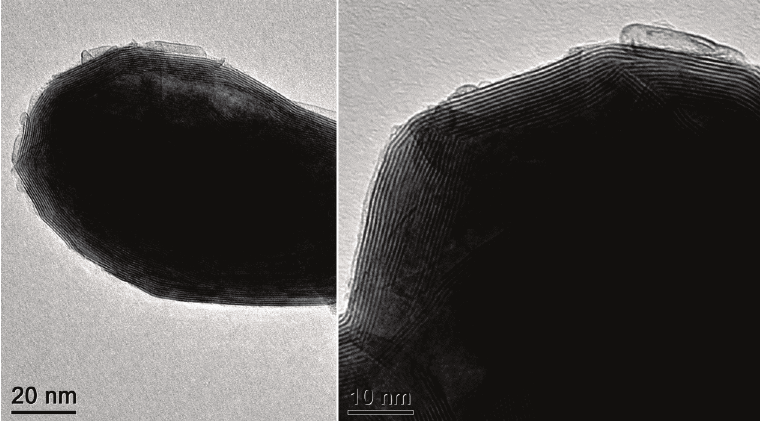
Figure 6. TEM image of the attached daughter single wall fullerene-like nanoparticles generated by plasma treatment of multiwall fullerene-like WS